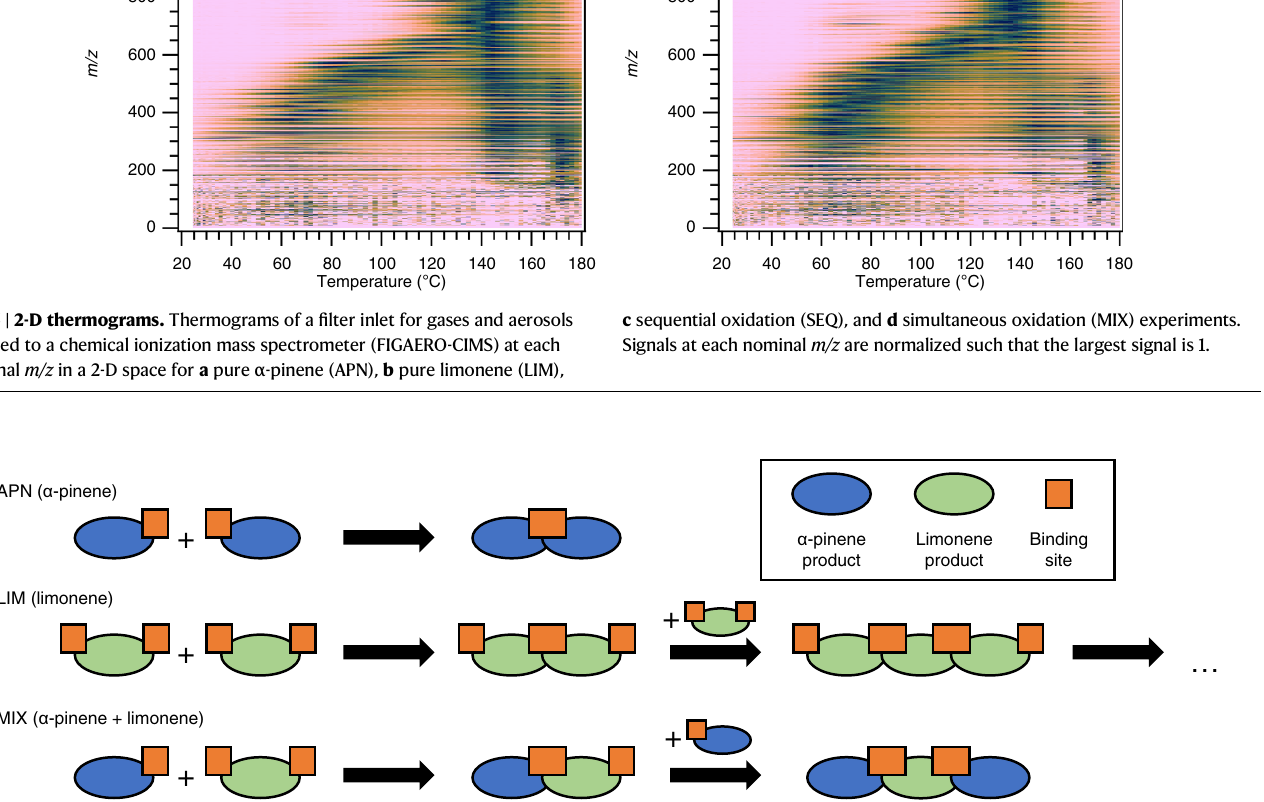
higher number of doublebonds in the precursor molecule. Thismay lead to much higher oligomerization degrees for secondary organic aerosol (SOA) formed in pure limonene (LIM) experiment compared to in pure α -pinene (APN) and simul- taneous oxidation (MIX) experiments.